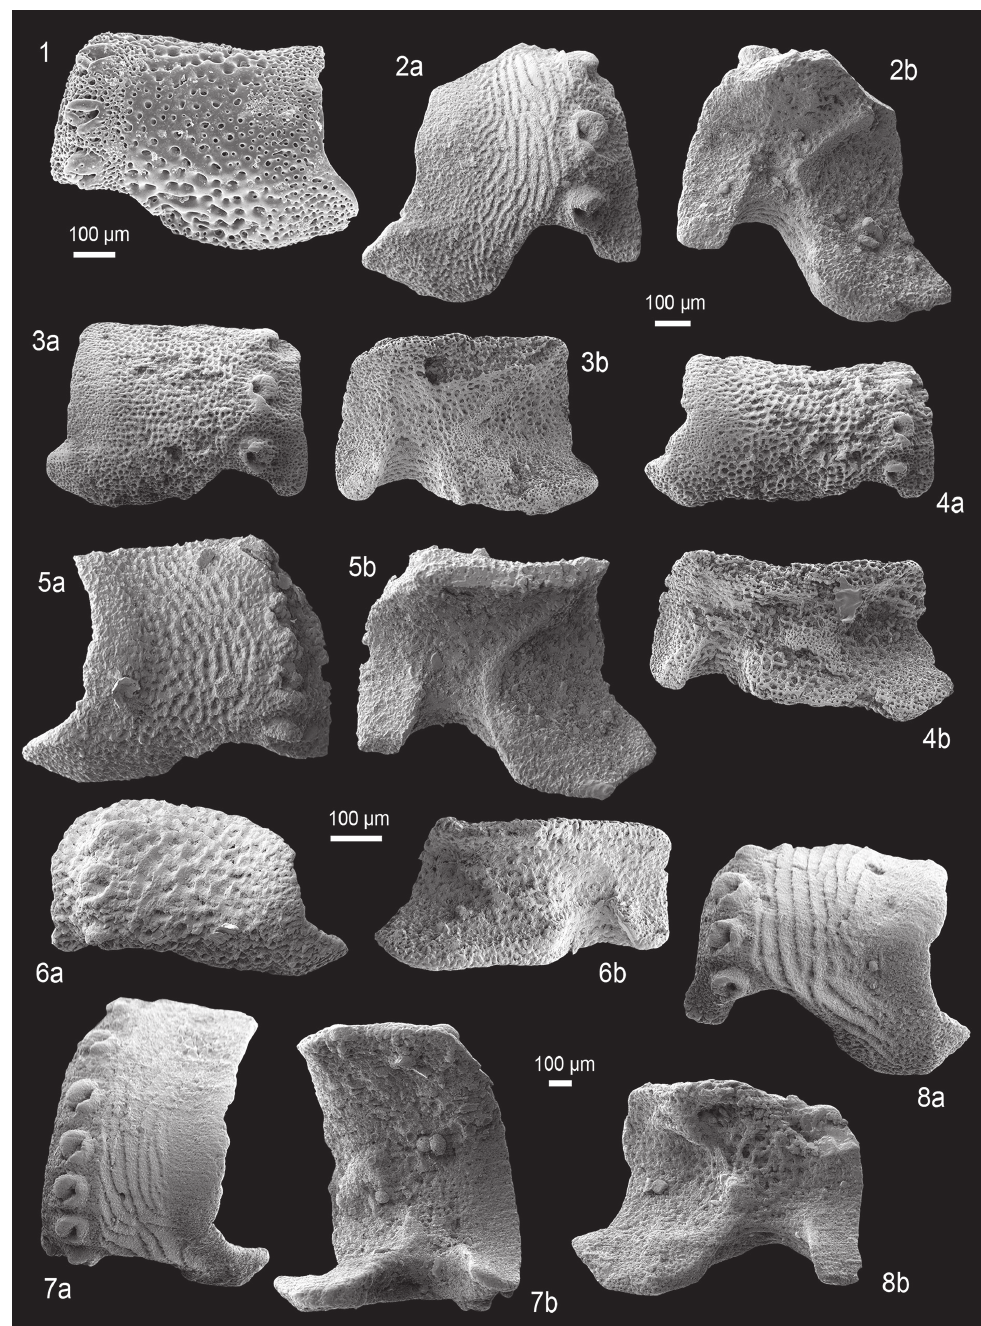
Fig. 11. Lateral arm plates (LAPs) of fossil and Recent ophiacanthid brittle stars in external (a) and internal (b) views. 1. Ophiologimus hexactis H.L. Clark, 1911, Recent, median LAP in external view. 2-4. Ophiologimus martynovi sp. nov. from the latest Aptian to earliest Albian (Early Cretaceous) of Blake Nose, NE Atlantic. 2. GZG.INV.78532 (holotype), proximal LAP. 3. GZG.INV.78533 (paratype), median LAP. 4. GZG.INV.78534 (paratype), distal LAP. 5-6. Ophiologimus aiodipius sp. nov. from the latest Aptian to earliest Albian (Early Cretaceous) of Blake Nose, NE Atlantic. 5. GZG.INV.78536 (holotype), proximal LAP. 6. GZG.INV.78537 (paratype), median LAP. 7-8. Ophiologimus rugosus (Kutscher & Jagt, 2000) comb. nov. from the early Maastrichtian (Late Cretaceous) of Rügen, Germany. 7. GZG. INV.78539, proximal LAP. 8. GZG.INV.78540, median LAP. One common scale bar per species is